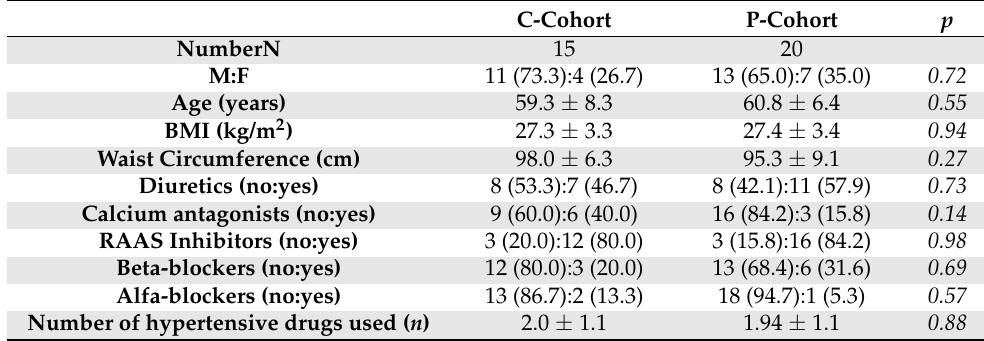
Table 1. Baseline anthropometric and clinical data of the study